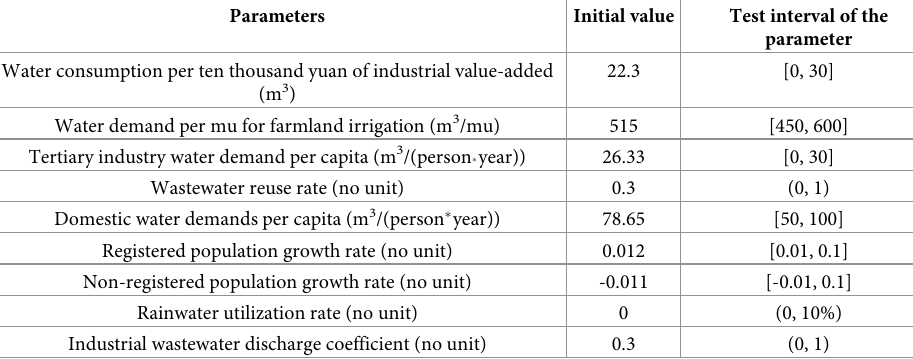
Table 4. Parameters used for driving factors